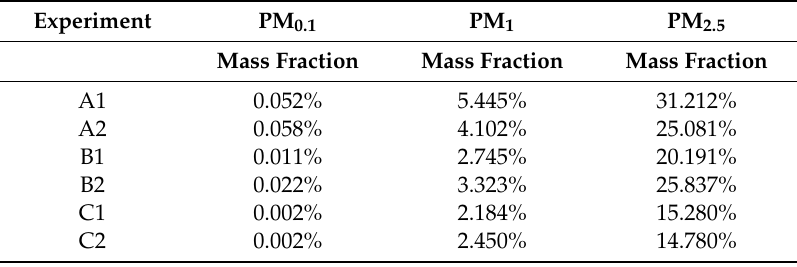
Table 5. Particle matter as mass and number fraction for each